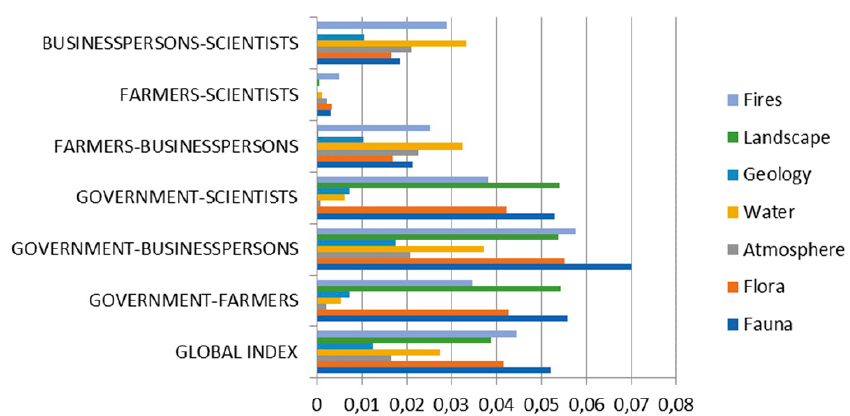
Figure 3. Global and specific indexes of conflict between each pair of stakeholders regarding conservation objectives.